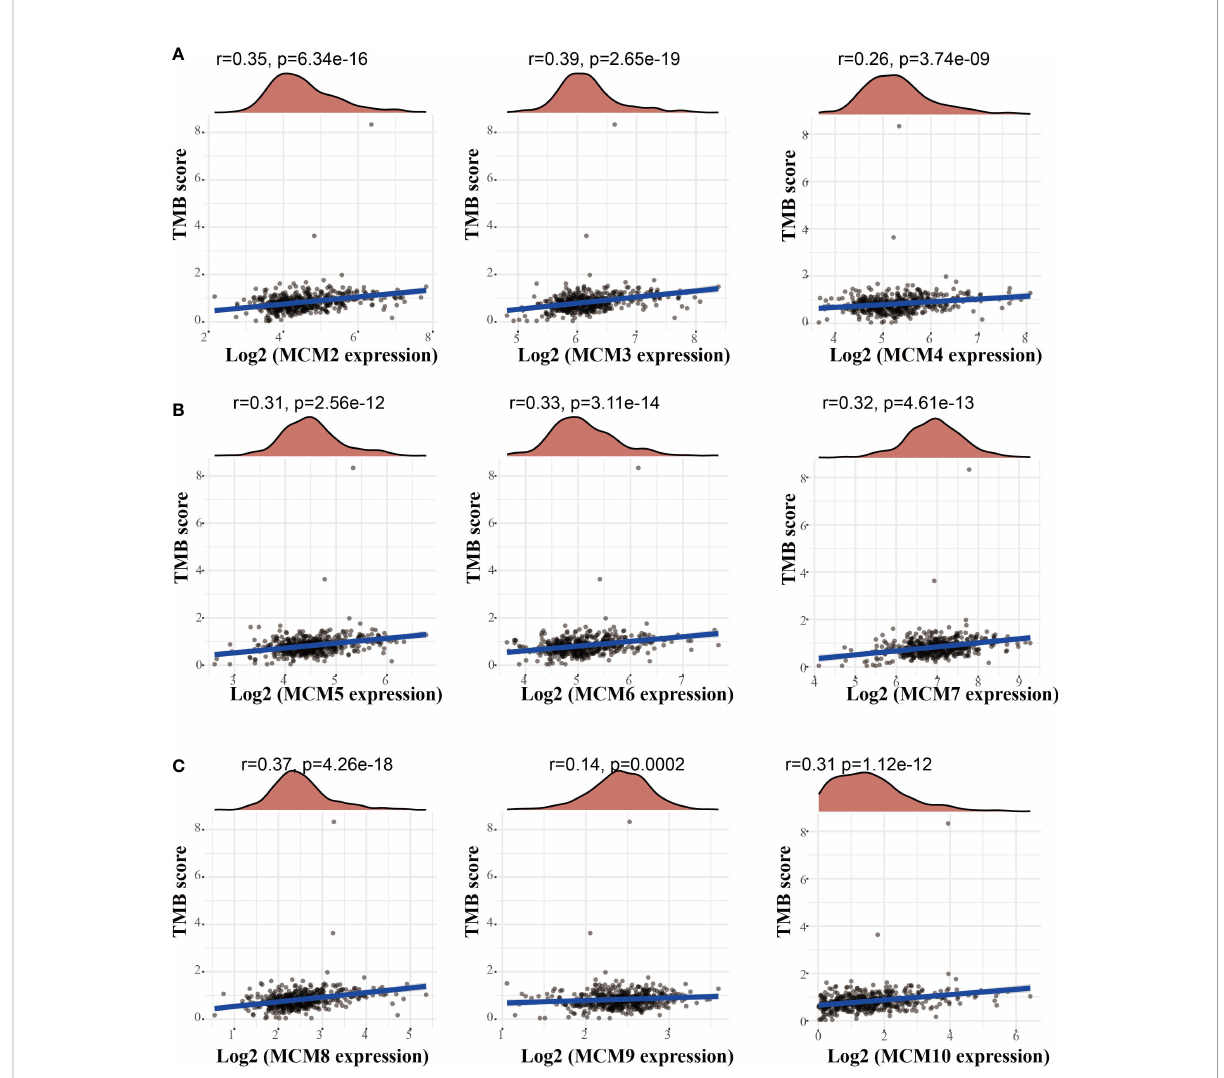
FIGURE 12 Analysis of the correlation between MCMs and TMB. (A – C) Analysis of the correlation between MCMs expression and TMB in glioma. TMB, tumor mutational